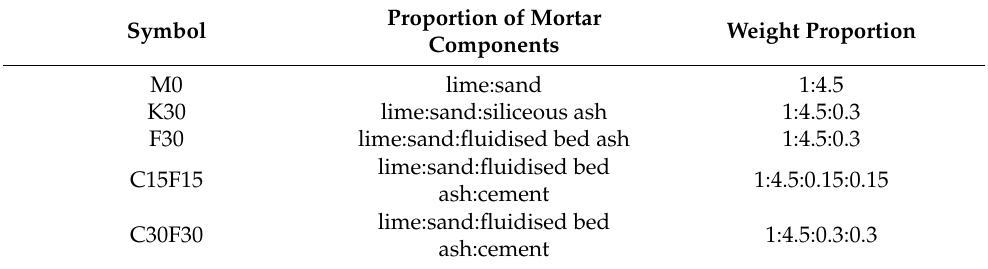
Table 2. Lime mortars used in the